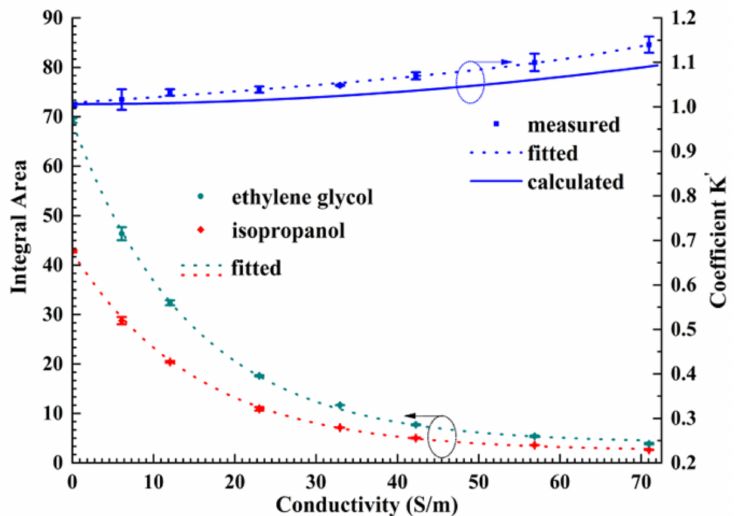
Figure 2. Relative ratio of the signal strength of built-in external standard and the sample with different conductivity, which corresponds to the trend of coefficient K (cid:48)